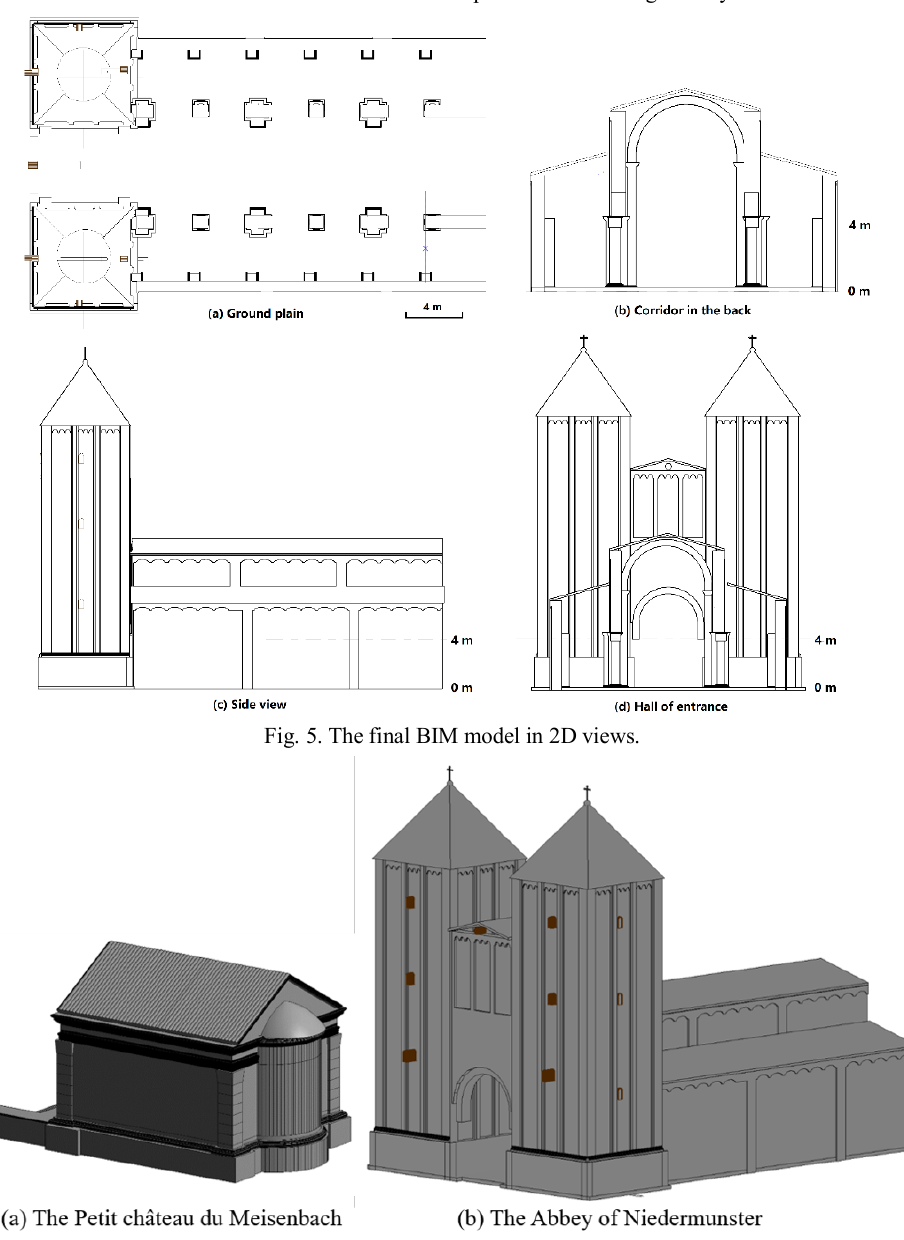
Fig. 6. The obtained 3D parametric